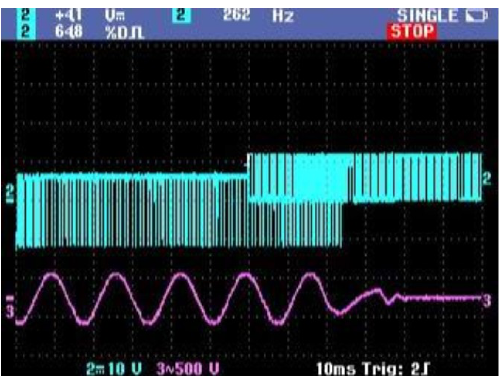
Figure 9. Communication signal between the WEG station and the BYD bus after implementing a filter with capacitors and